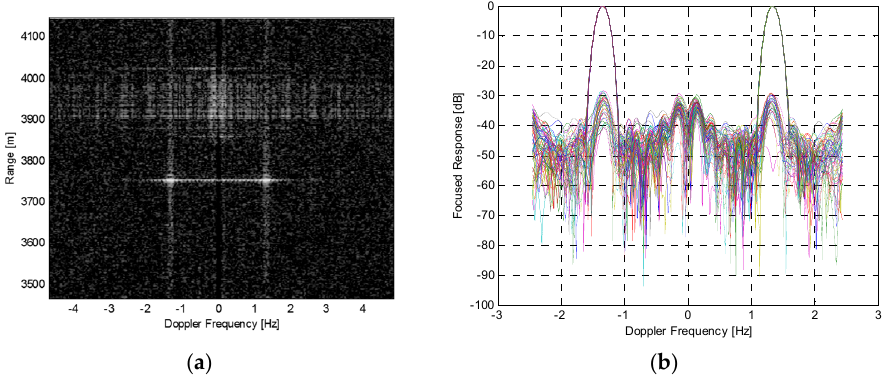
Figure 6. ( a ) Range-Doppler map with the focused moving target clearly visible; ( b ) Azimuth IRF.